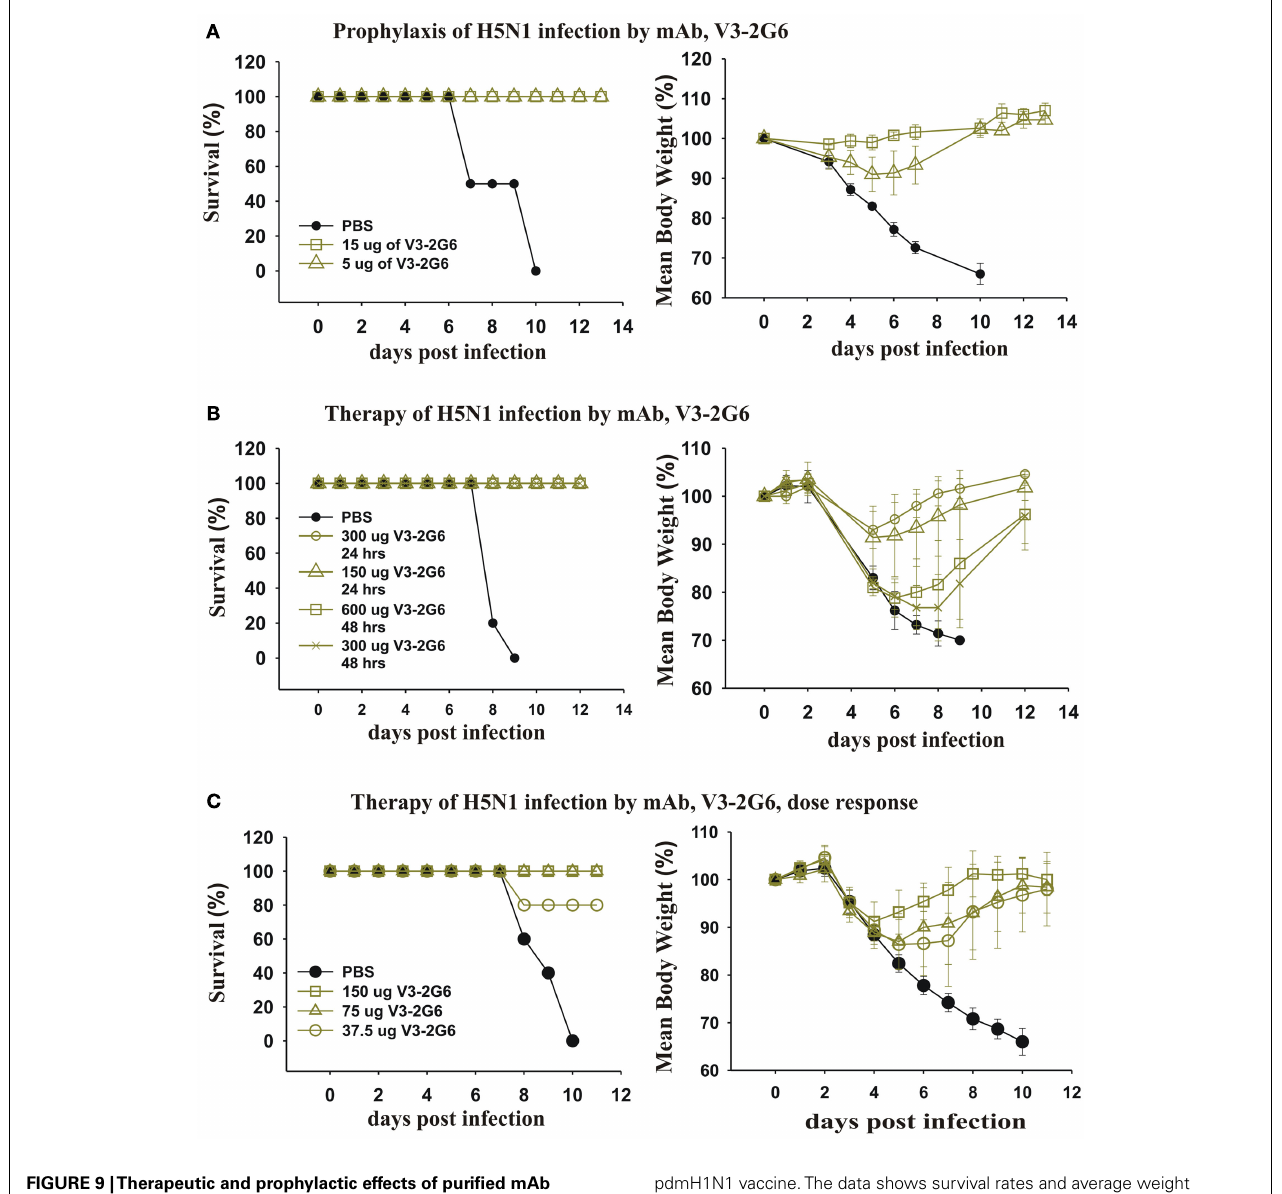
FIGURE 9 |Therapeutic and prophylactic effects of purified mAb against lethal infections with H5N1 avian influenza virus. (A) Twenty-four hours before intranasal infection with 2 × 10 5 PFU of A/Hong Kong/213/2003 (H5N1) virus, three groups (five mice each) of BALB/c mice were injected intraperitoneally with PBS as a control, or 15 or 5 μ g ofV3-2G6 generated from a subject vaccinated with the